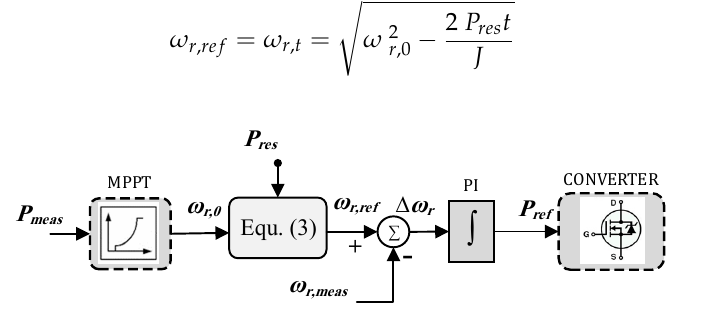
Figure 6. Fast power reserve emulation controller.